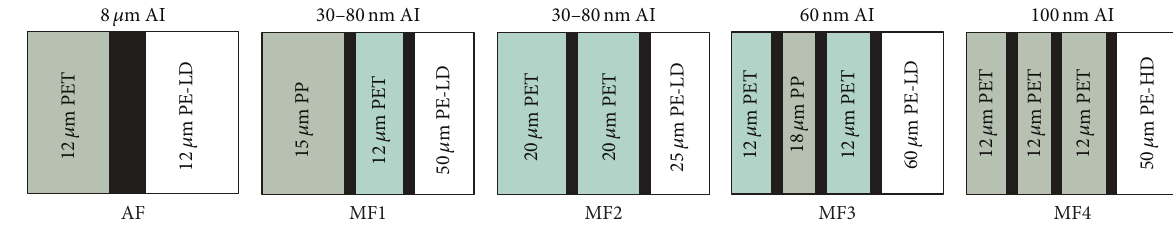
Figure 5: Illustration of an aluminum foil laminate (AF) and metallized polymer film MF